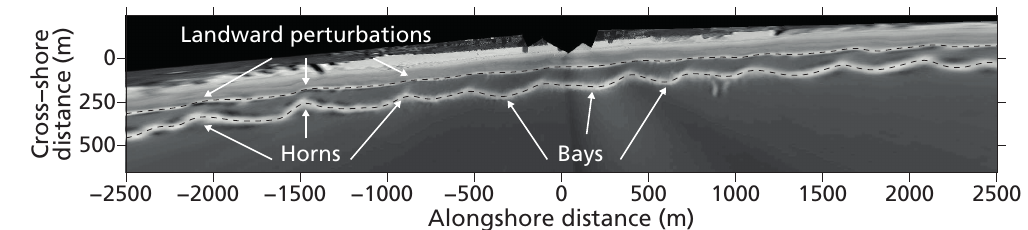
Figure 2. Example of a time-exposure image from the Gold Coast, Australia, showing the Idt coupling type, with a crescentic outer bar and a terraced inner bar with landward perturbations coupled to the alongshore positions of the outer-bar horns. The dotted lines indicate the video-derived inner and outer barlines. Source: Price et al.